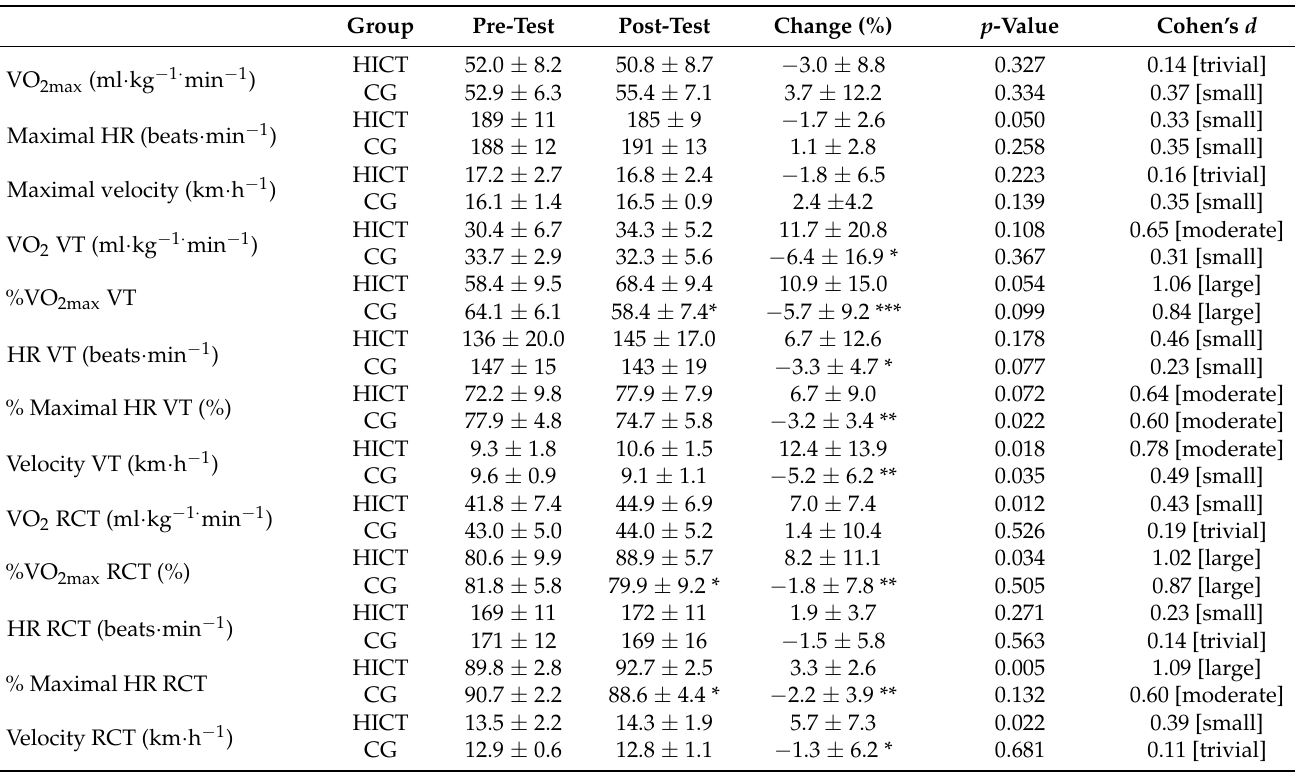
Table 2. Physiological characteristics of participants (mean ± SD ).